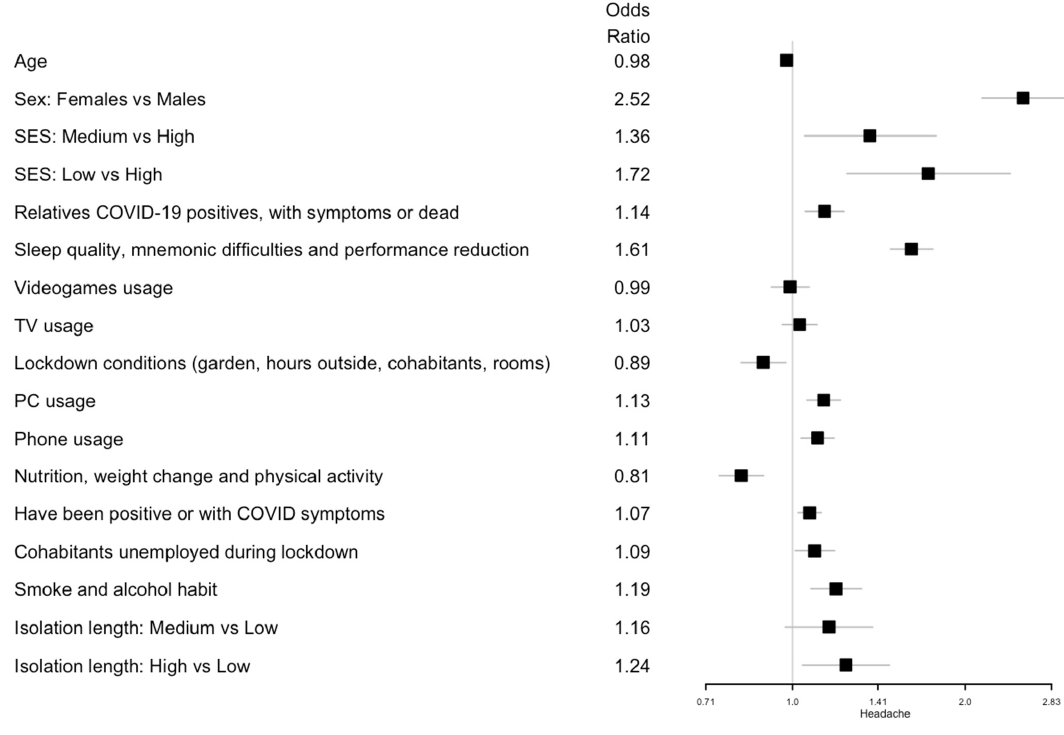
Figure 2. Forest plots for the effect of the covariates on headaches. The squares represent the odds ratios and the lines depict the confidence intervals estimated by the logistic regression.